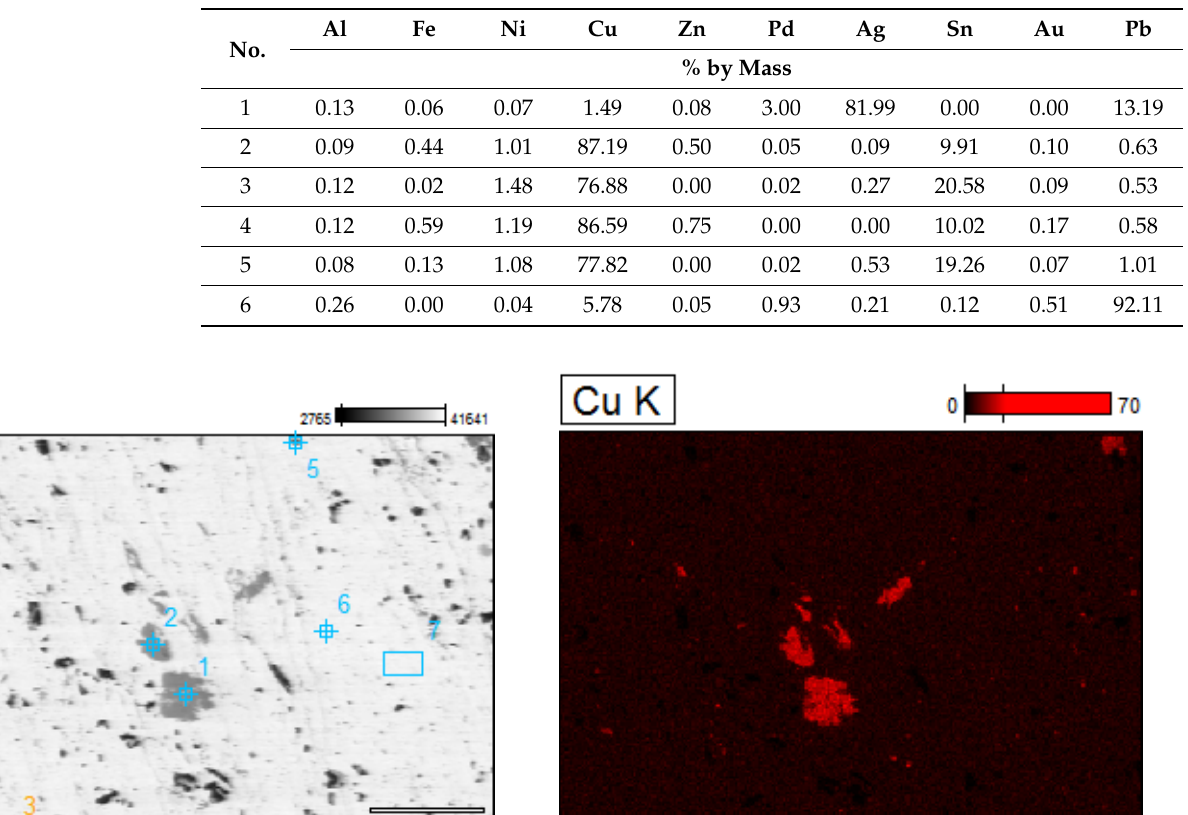
Table 9. Point chemical compositions of the lead ingots after melting with PCB pyrolyzate “new”,